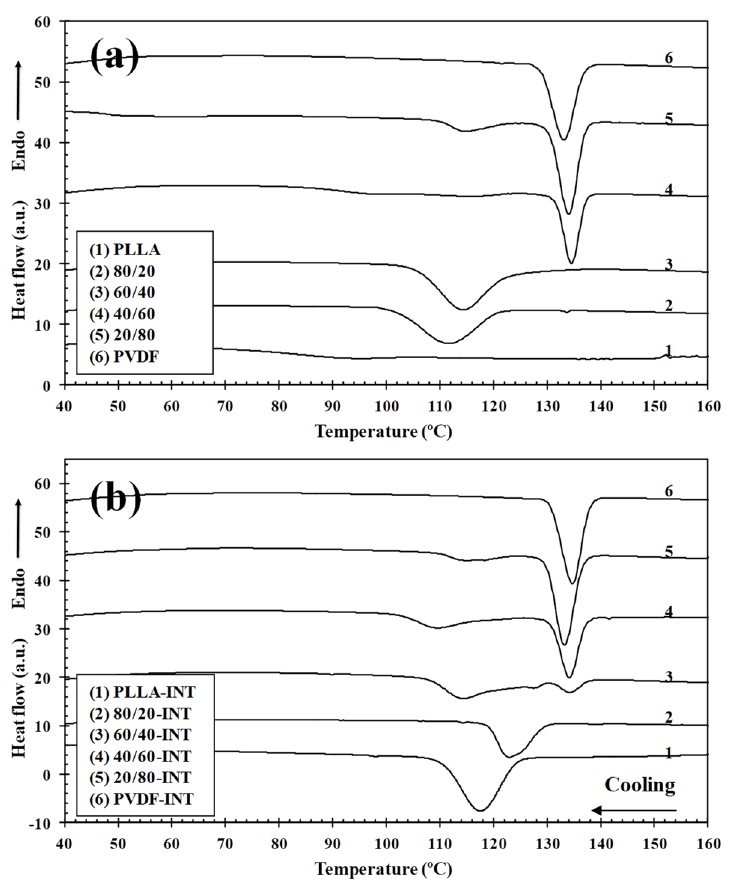
Figure 6. DSC thermograms of the non-isothermal crystallization of ( a ) binary PLLA/PVDF and ( b ) ternary PLLA/PVDF/INT-WS 2 hybrid nanocomposites obtained during cooling from the melt to room temperature at 10 ◦